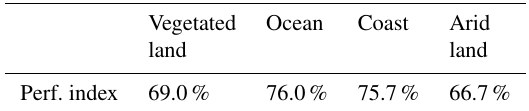
Table 3. Performance indexes for the different background surfaces. Table 4. Statistical indexes obtained in the comparisons of PNPR v2 retrievals with GPM-KuPR and TRMM-PR